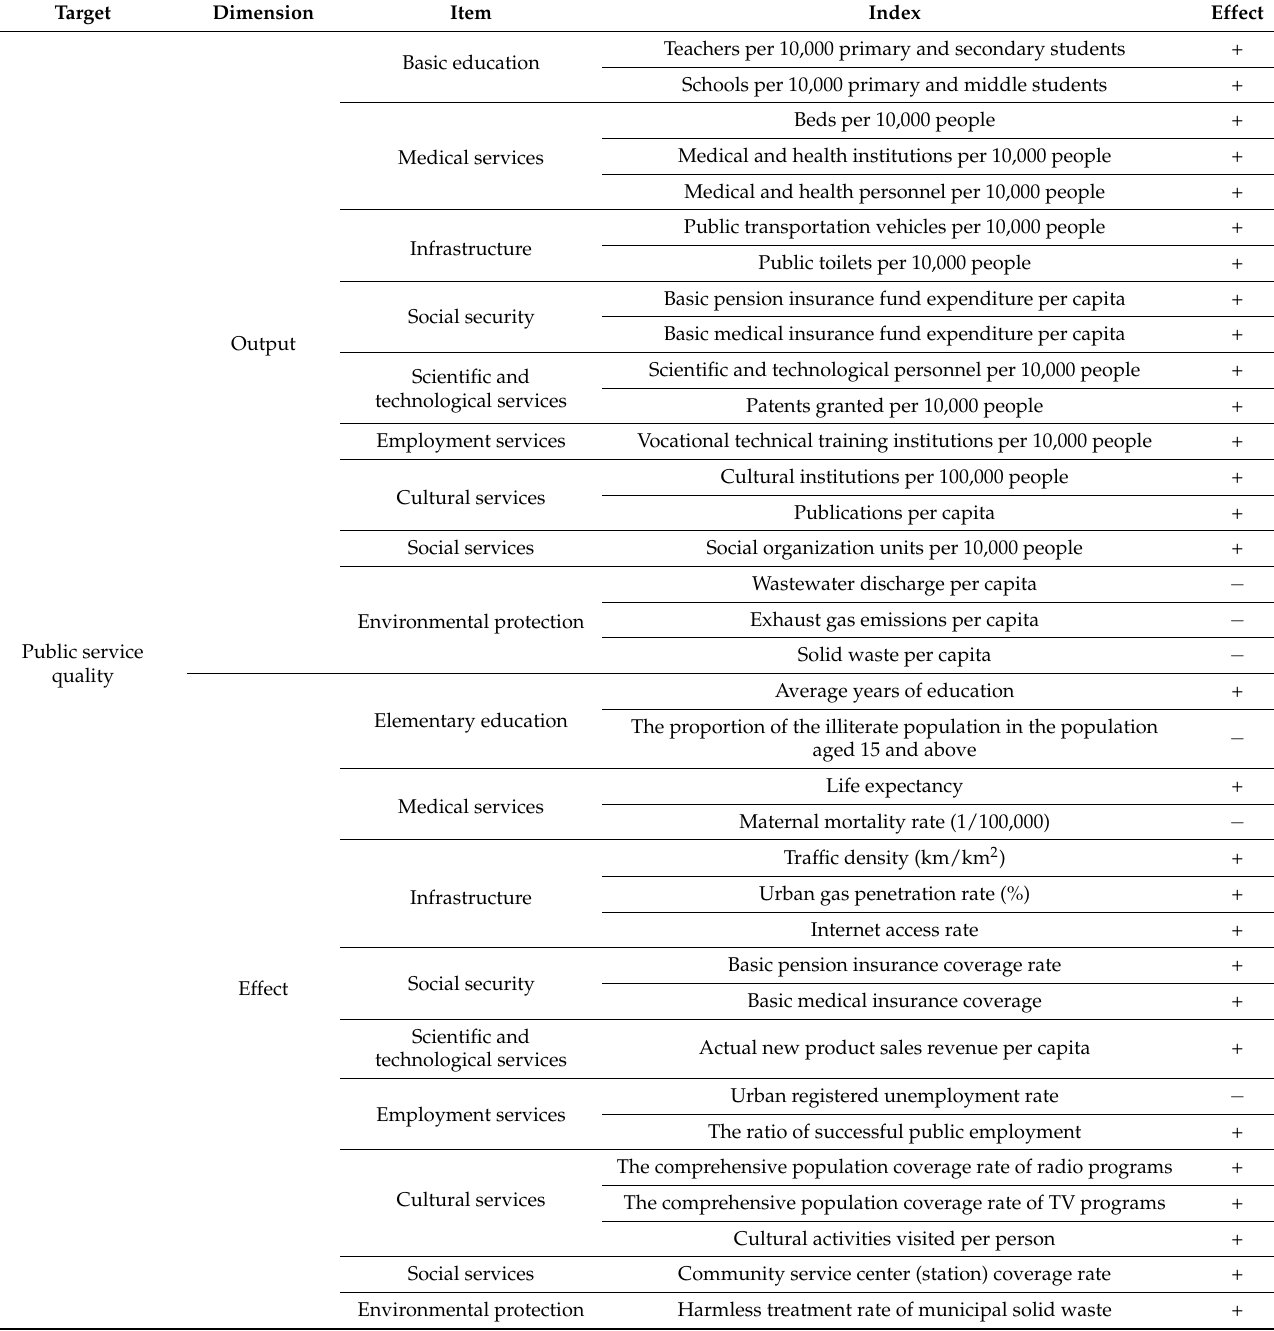
Table 1. Evaluation index system of public service